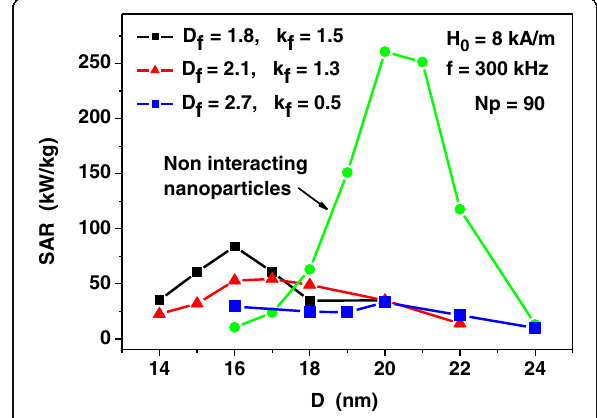
Fig. 4 SAR as a function of the average nanoparticle diameter D for dilute assemblies of fractal clusters of nanoparticles with various fractal descriptors. The SAR of the assembly of non-interacting nanoparticles is calculated by means of Eqs. (1) and